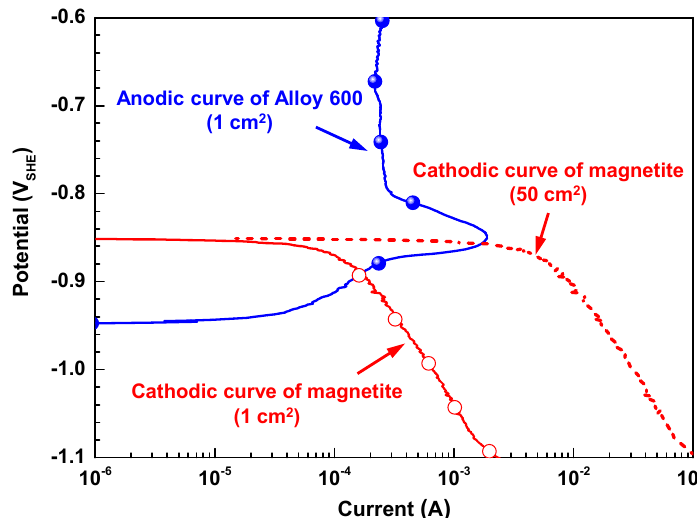
Figure 5. Electrochemical behavior of Alloy 600 and magnetite in 10 wt% NaOH solution at 280 ○ C.